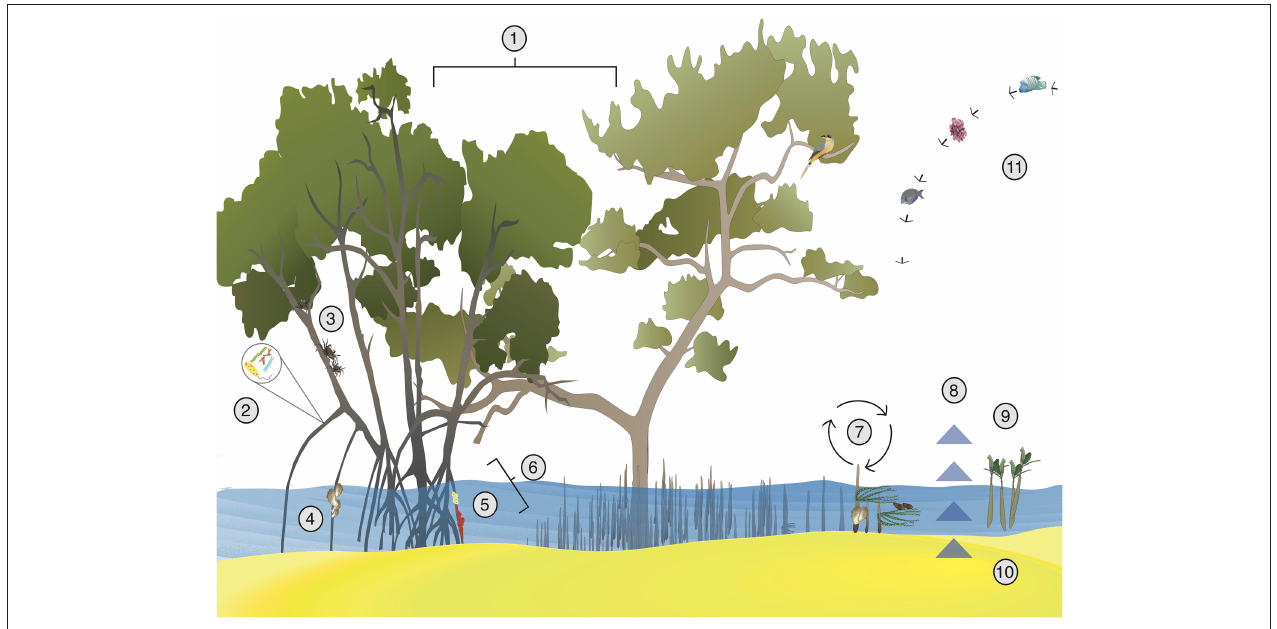
FIGURE 2 | Examples of positive interactions in mangrove ecosystems. (1) Multi-species plantations can sequester more carbon in sediments (Chen et al., 2012) and can increase root yields ( Lang’at et al., 2013). (2) Microbial communities receive food from mangrove root exudates and can help recycle nutrients (Bashan and Holguin, 2002 ). (3) Mixed stands of mangroves can provide association defense against herbivory (Erickson et al., 2012). (4) Mangrove roots allow for oyster recruitment and reduce sedimentation stress, and the presence of oysters in turn supports other species (Aquino-Thomas and Proffitt, 2014). (5) Mangroves provide carbon to sponges and sponges provide nitrogen to mangroves ( Ellison et al., 1996). (6) Mangrove roots provide habitat for sponges and tunicates, which protect mangrove roots from harmful isopods (Ellison and Farnsworth, 1990). (7) In a facilitation cascade, mangrove pneumatophores trap algae and oysters, which act as secondary foundation species and support diverse mollusk communities ( Bishop et al., 2012). (8) Mangrove plantations sequester carbon in sediments (Mcleod et al., 2011 ), which is affected by planting density and may be facilitated by top predators (Atwood et al., 2015). (9) Other plant species can increase recruitment of mangroves by trapping seeds and ameliorating abiotic stress (McKee et al., 2007). (10) Higher densities of mangroves can increase seedling success and sediment accumulation, which may allow for more resilience to sea level rise (Huxham et al., 2010). (11) Nearby coral reefs protect mangroves from wave action, while mangroves reduce sedimentation stress and increase reef fish biomass on reefs (van de Koppel et al., 2015). See acknowledgments for vector